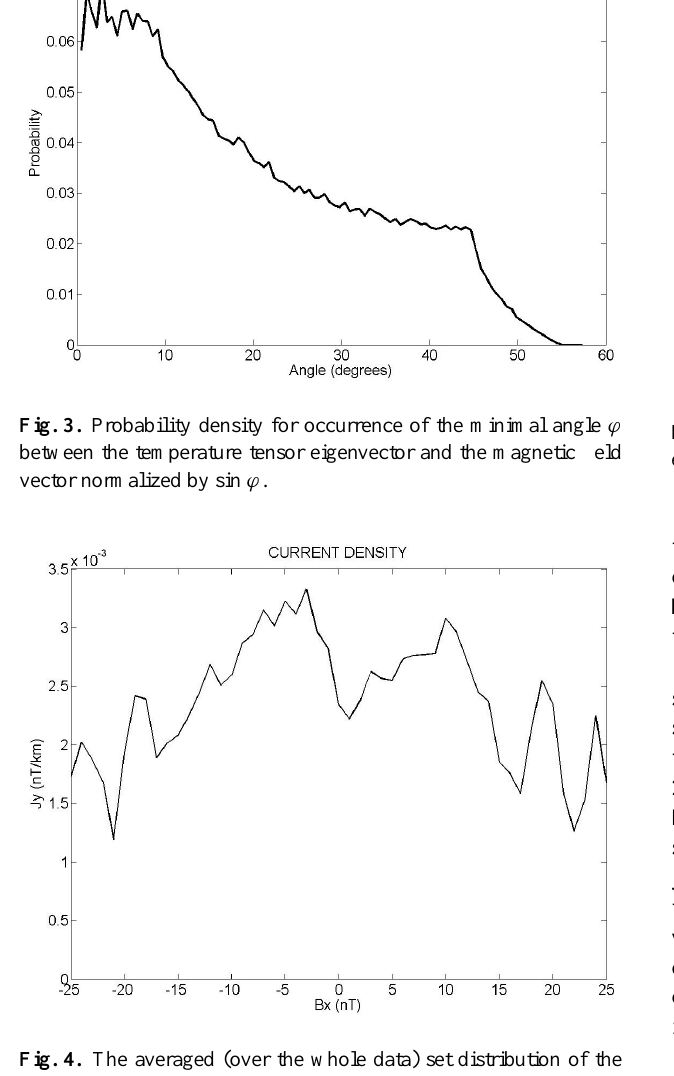
Fig. 4. The averaged (over the whole data) set distribution of the electric current versus the magnetic field component B x .